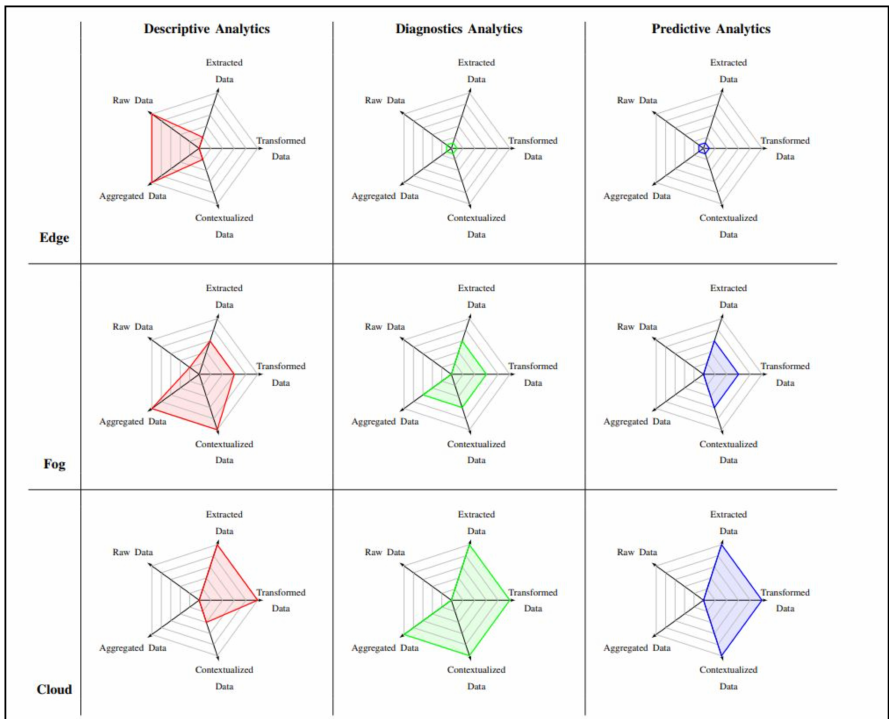
Figure 1. IoT-Edge-Fog-Cloud Architecture: Resource Capability